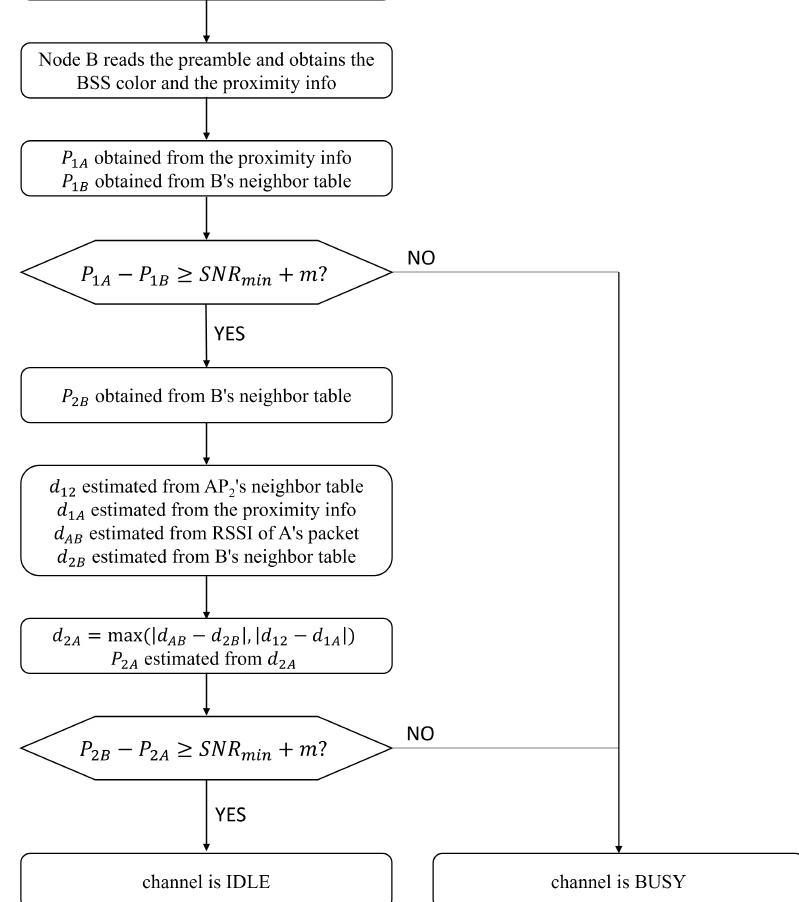
Figure 6. A flow diagram illustrating the operation of the proposed